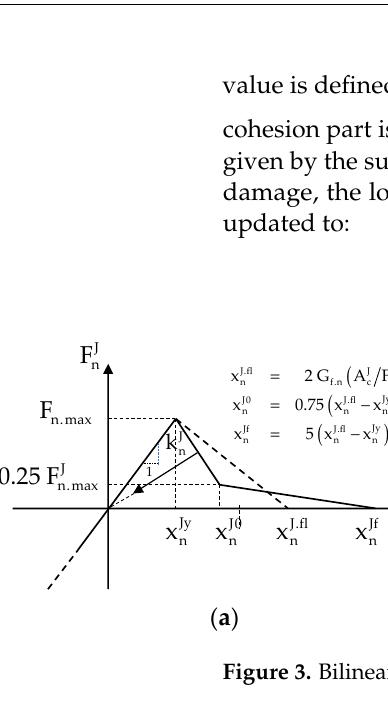
state when the maximum damage was reached.